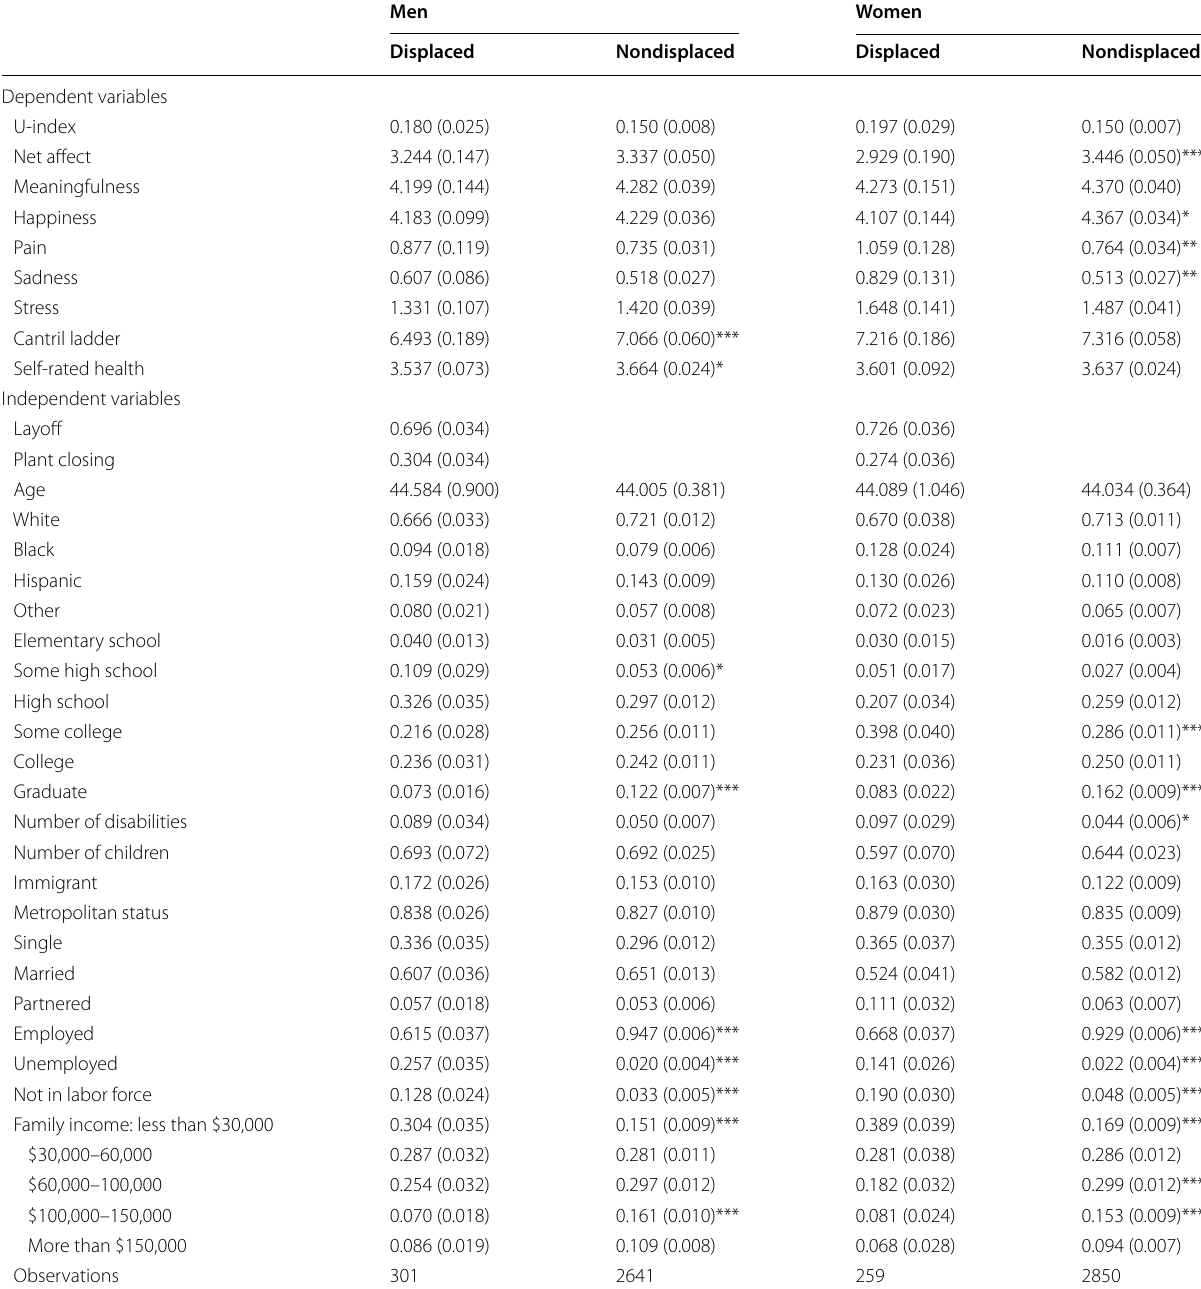
Table 1 Descriptive statistics by sex and displacement